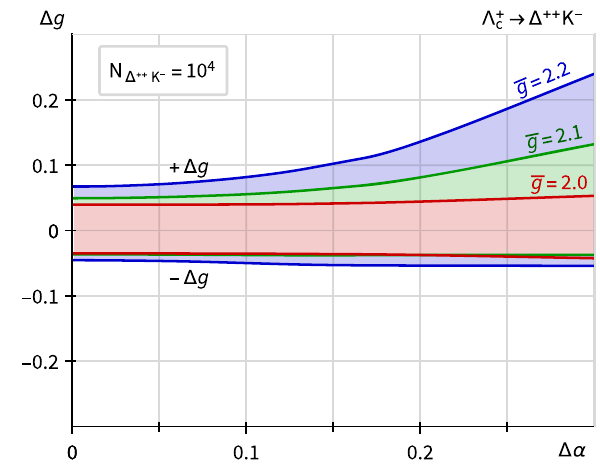
ous expected values of g -factor g , stated in the plot. Calculation results for IR3 configuration, considering Λ + c → Δ ++ K − decay channel, assuming α = − 0 .